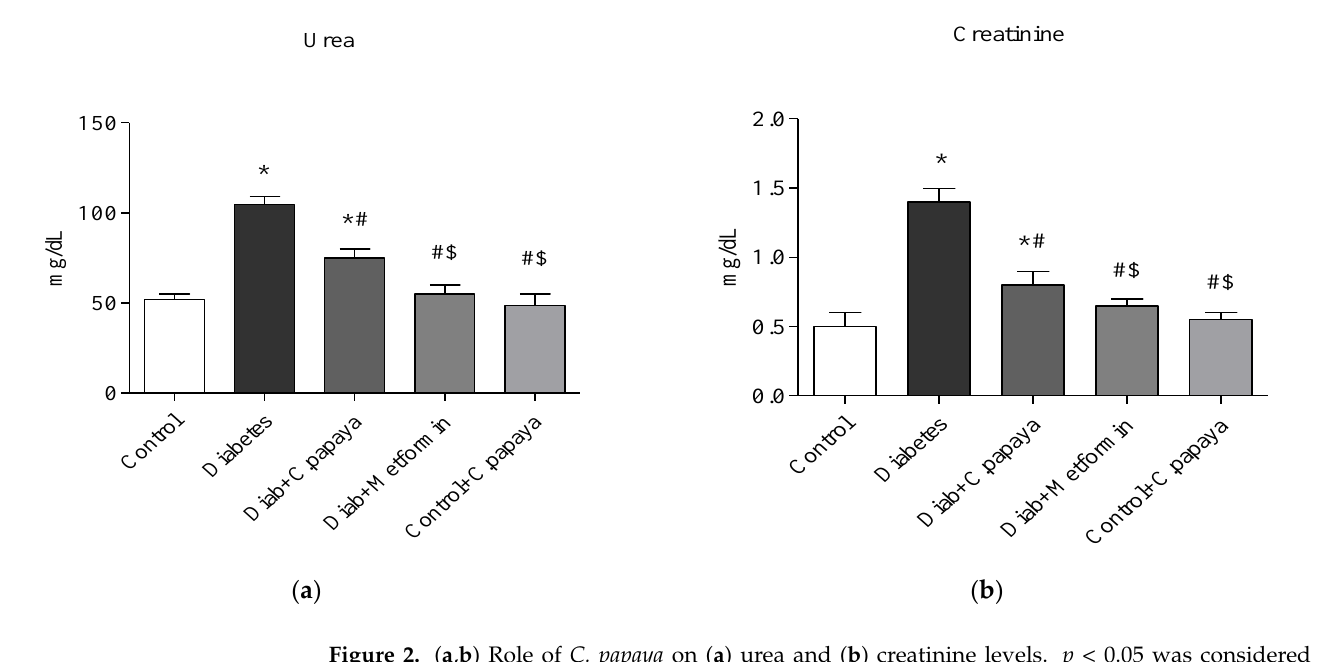
Figure 2. ( a , b ) Role of C. papaya on ( a ) urea and ( b ) creatinine levels. p < 0.05 was considered statistically significant among the groups: *-control; #-diabetes; $- C. papaya -treated T2DM.